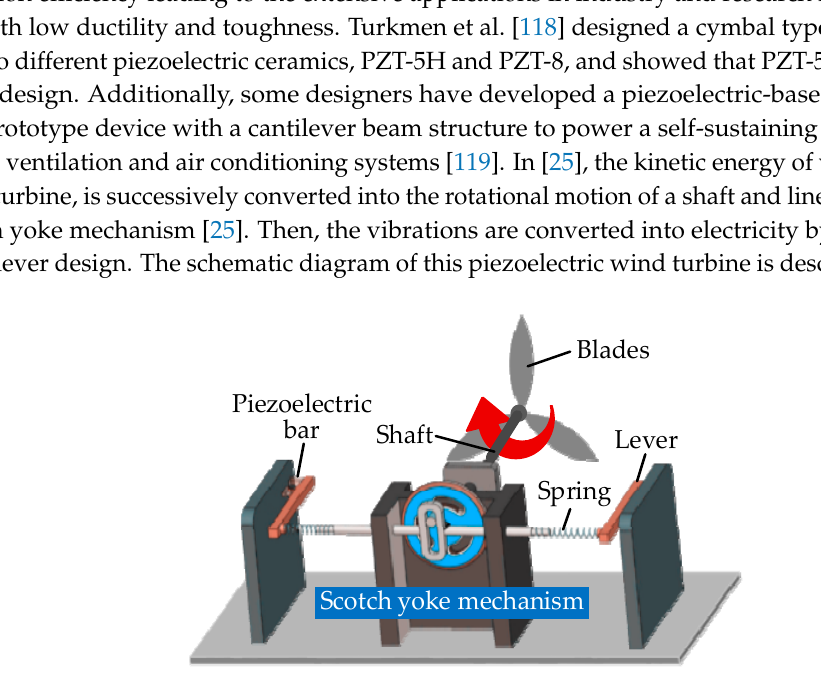
Figure 12. Schematic of a piezoelectric wind turbine: an internal structure of the device.